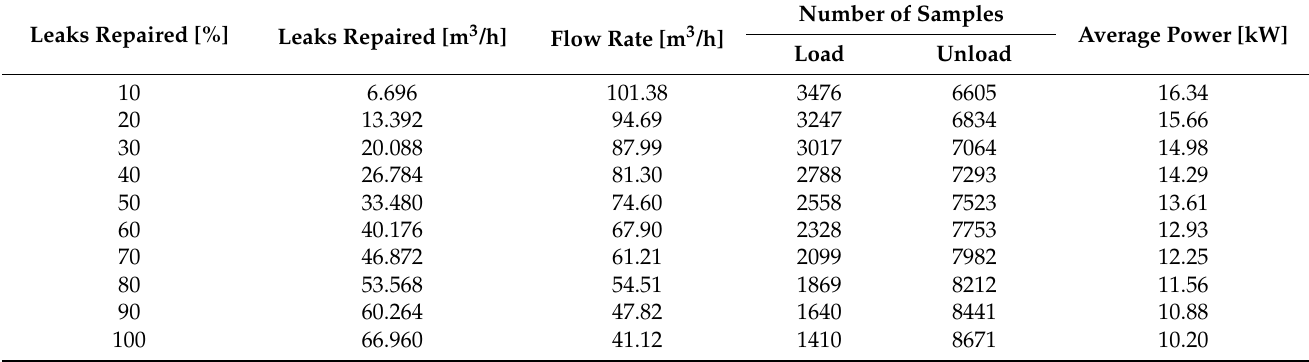
Table 7. Average air compressor power after the leaks repair during the normal operation period.